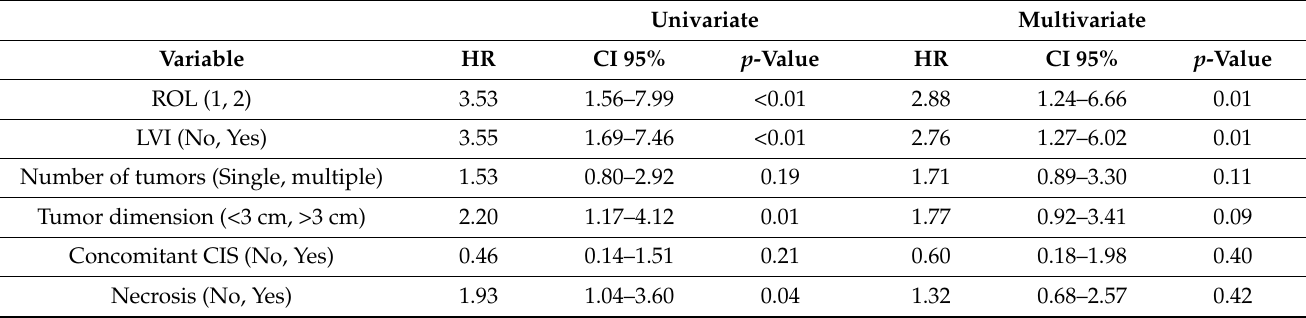
Table 3. Univariate and multivariate analysis of time to progression (40 events). Univariate Multivariate